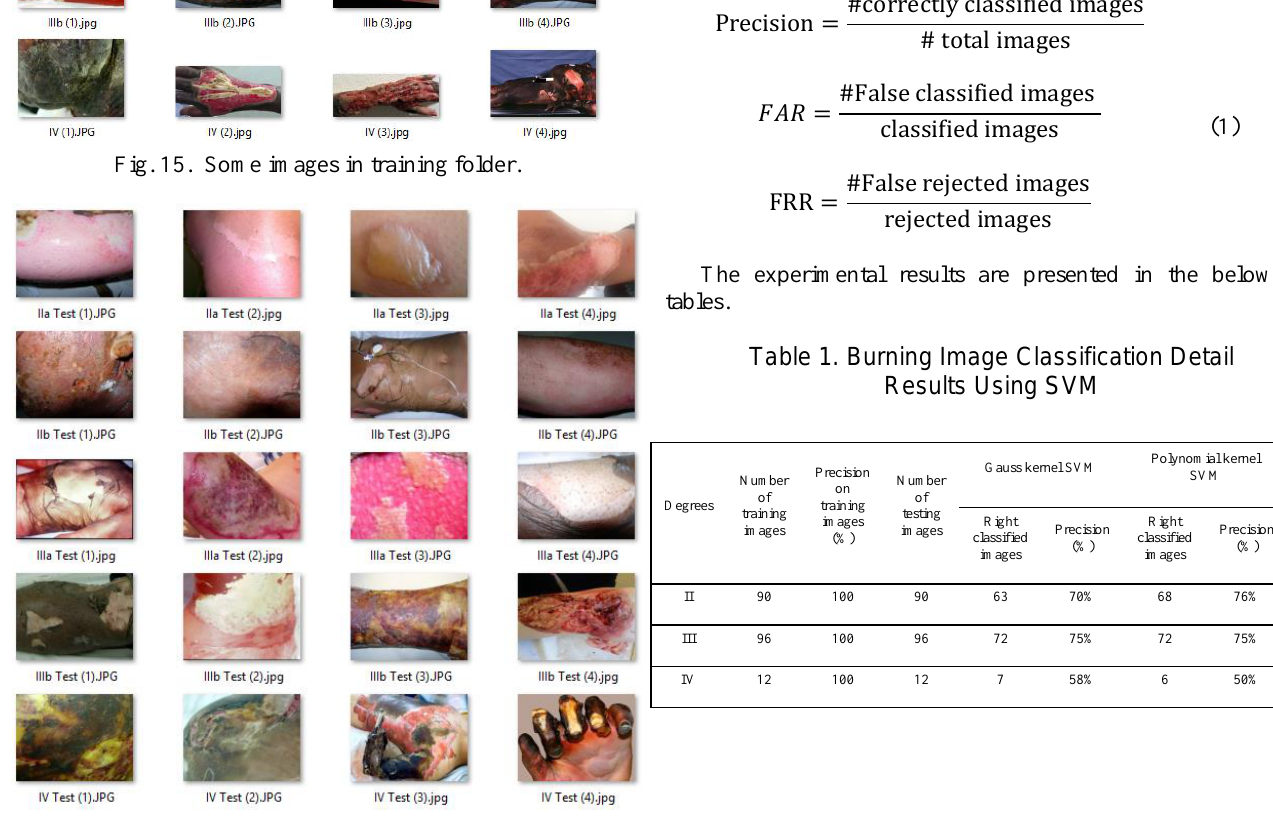
Fig. 16. Some images in testing folder.